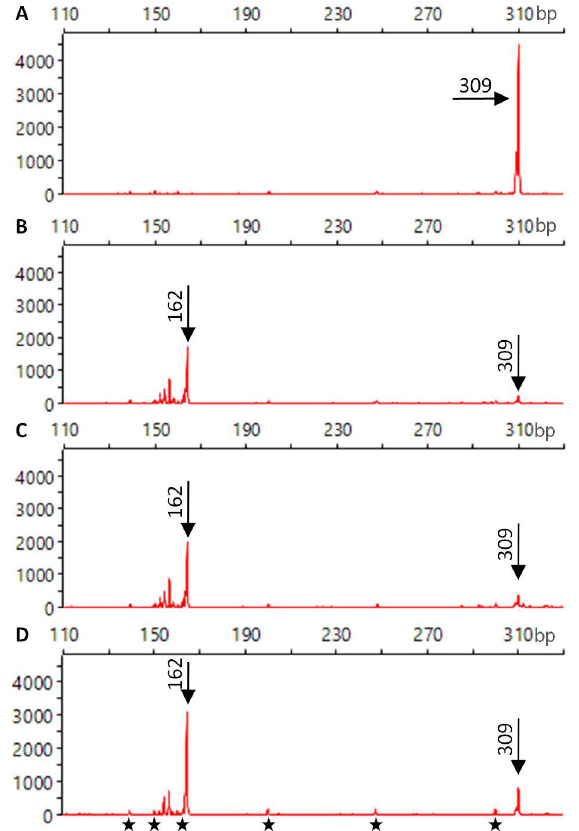
Figure 5. Electropherograms of ROX-labelled DNA fragments detected by a capillary electrophoresis. Untreated DNA of 309 bp in length ( A ), DNA incubated with the untreated RNP complex—control ( B ), DNA incubated with the RNP complex containing ECD-measured Cas9 ( C ), DNA incubated with the ECD-measured RNP complex ( D ). Stars—GeneScan™ 500 LIZ size